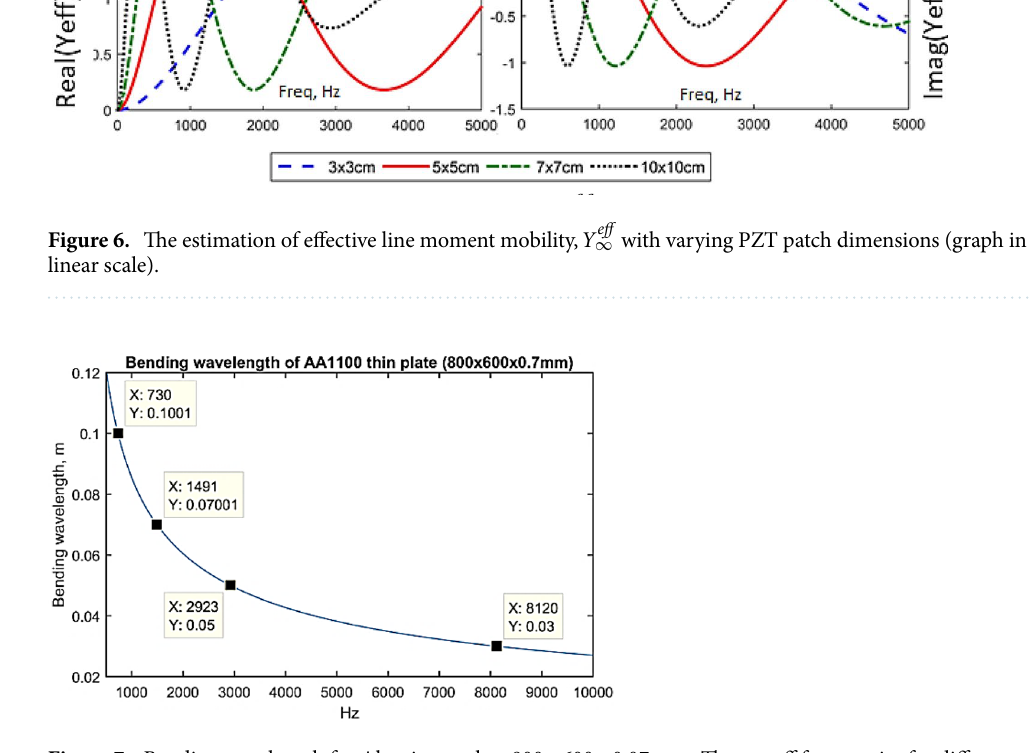
Figure 7. Bending wavelength for Aluminum plate 800 × 600 × 0.07 mm. The cut off frequencies for different patch size (3 cm, 5 cm, 7 cm and 10 cm) are